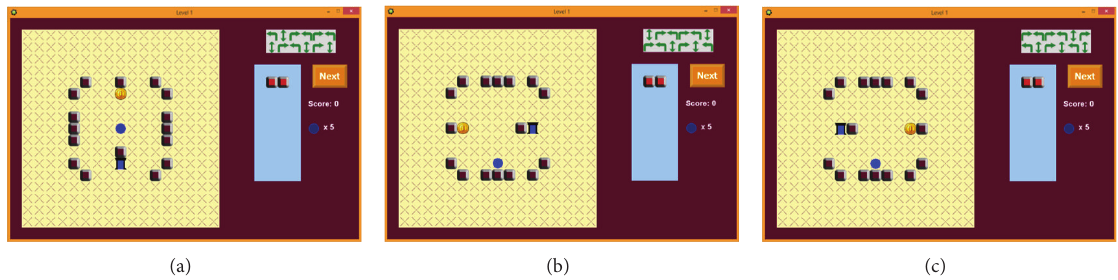
Figure 5: Screenshots from Game R that show the orb moving. From left to right: the starting position, after a 90-degree left rotation, and after a 180-degree